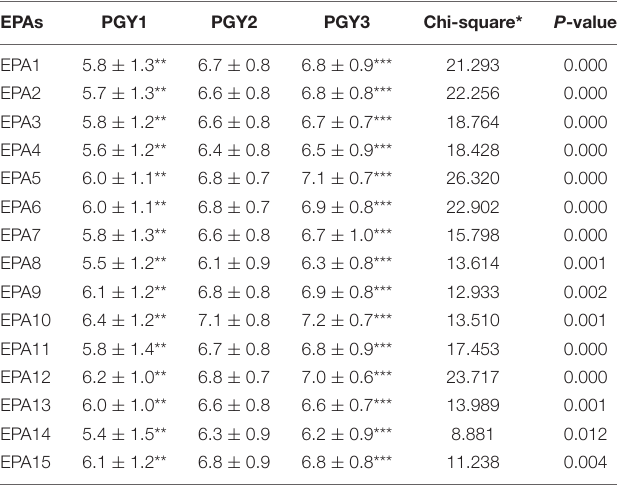
TABLE 4 | Scores of director-assessment in different postgraduate years (PGYs).